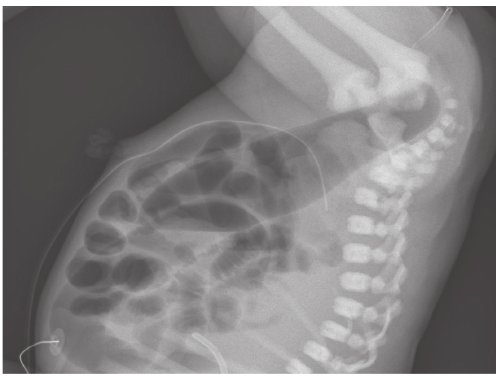
Figure 2: X-ray of abdomen at 24hours of age before colostomy. A catheter is placed at the bottom of the anal